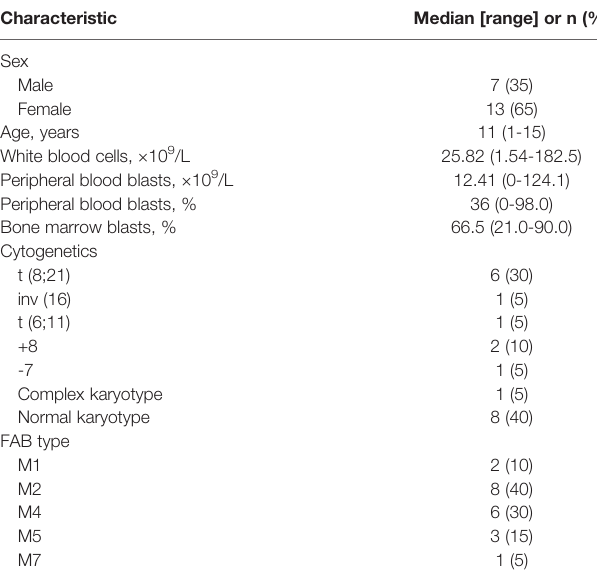
TABLE 1 | Baseline characteristics of the study